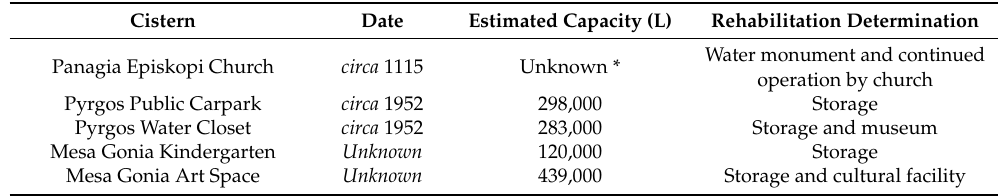
Table 3. Cistern Water Storage Capacity